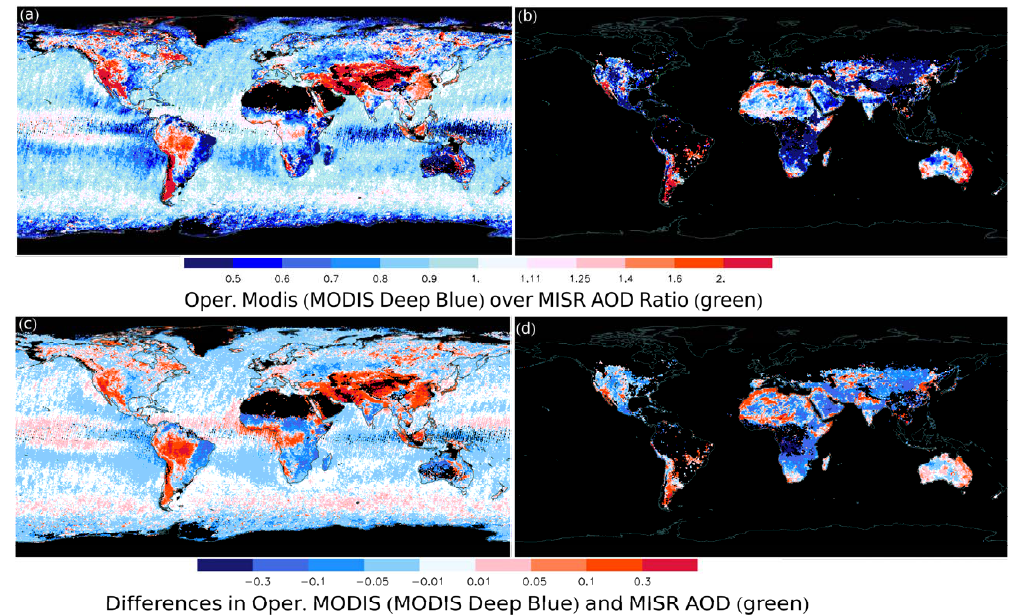
Fig. 3. (a) The ratio of operational MODIS DT over MISR AOD in green channel for year 2005–2007. (b) Similar to (a) but for MODIS DB. (c) The differences between operational MODIS DT and MISR AOD in green channel for year 2005–2007, and (d) Similar to (c) but for MODIS DB. Note the color scales are different between the top and the bottom